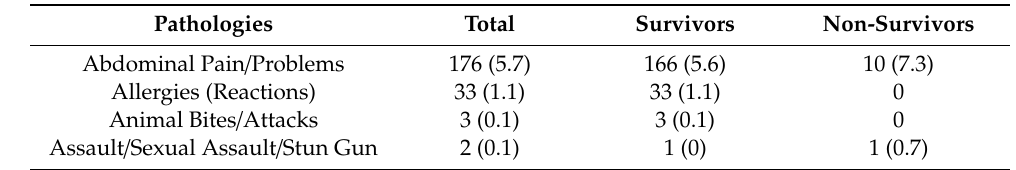
Table 3. Distribution of cases according to the Advanced Medical Priority Dispatch System (death statistics refer to mortality rates in less than 48